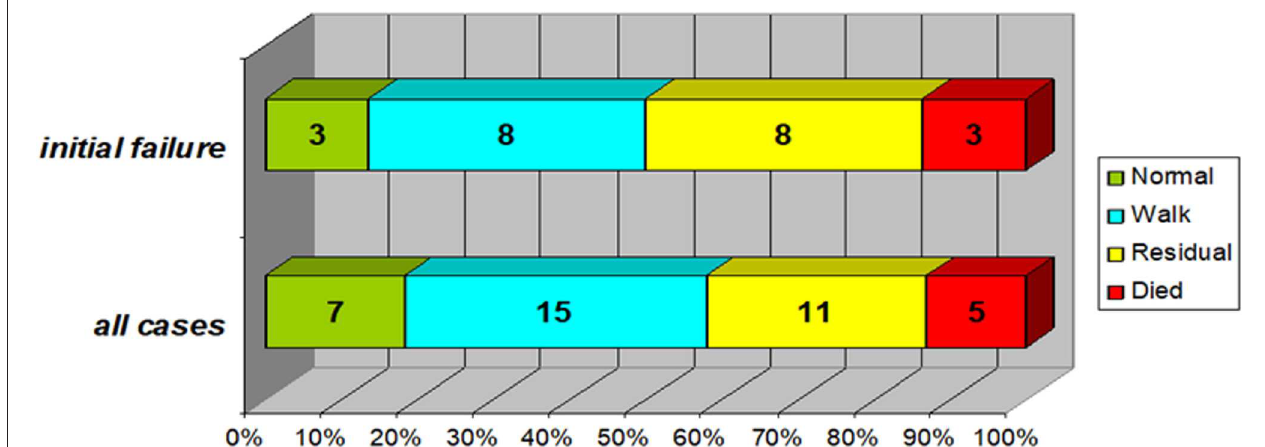
FIGURE 3 | Final outcome of the study group (In the subgroup of patients with initial treatment failure ( n = 22) compared to the whole study group). Normal: no neurological abnormalities and normal motor power. Walk: can walk unaided (if age-appropriate) despite minor weakness. Residual: significant residual weakness, cannot walk unaided. Favorable outcomes (patient can walk unaided) were present in 22 cases (58%); 7 of them had fully regained their power, while 11 (29%) had been discharged with minor residual weakness and 2 were still admitted. Those with initial treatment failure (top bar) were not significantly different regarding either mortality ( p = 0.46) or favorable outcome ( p =